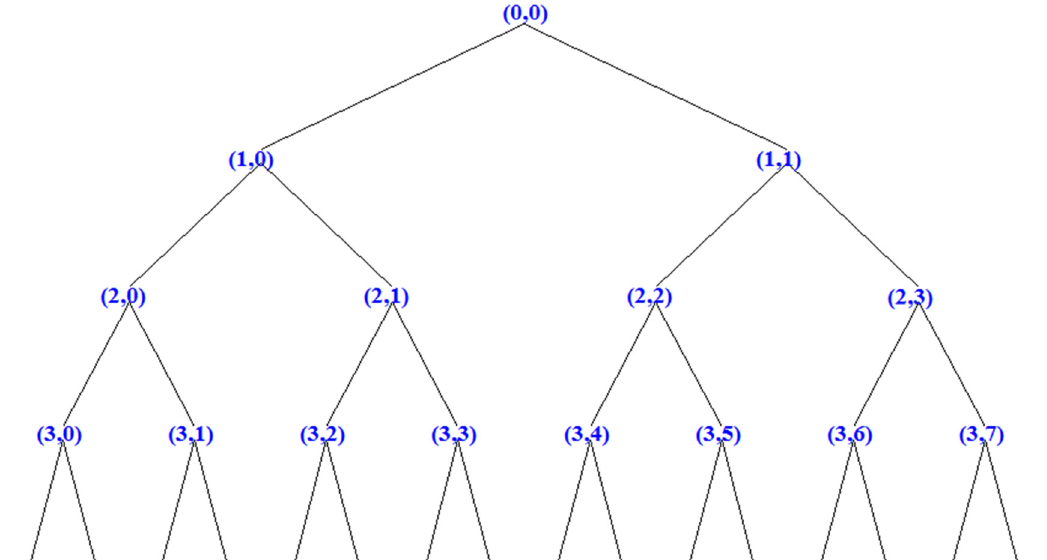
Figure 6. Structure of WPT tree.